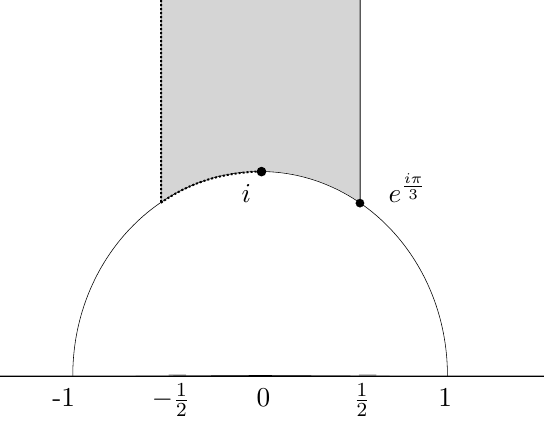
Figure 1 . The Fundamental domain of (cid:28) for X (1) = H = SL(2 ; Z